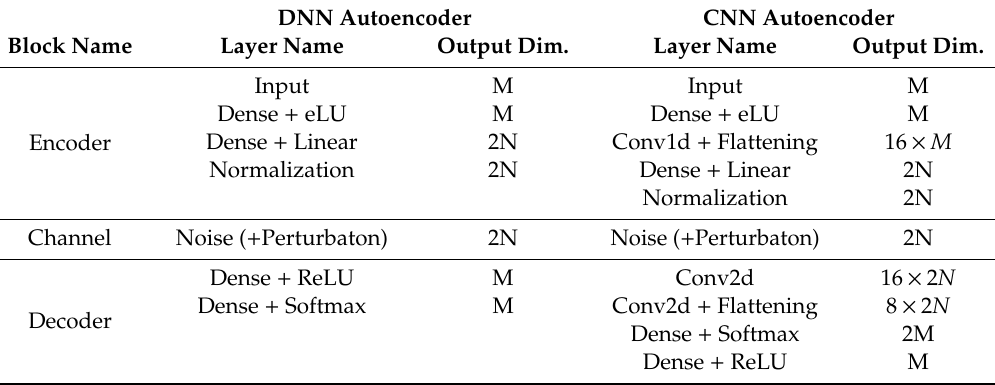
Figure 2. End-to-end autoencoder model. (a) Active jamming; (b) passive eavesdropping. The vocabulary table of the variables used is shown in Table 2. Table 1. The structure of the considered autoencoders.